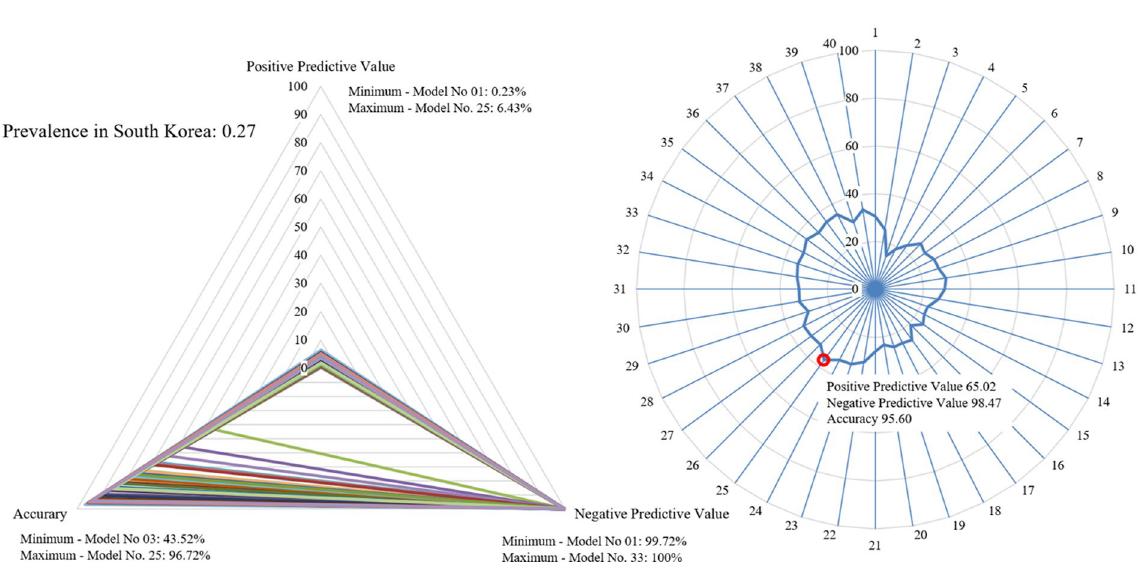
Figure 6. Comparison of each model considering screening performance affected by prevalence: South Korea. Triangle radar chart: positive predictive values, negative predictive values and accuracy of each model; polygonal radar chart: triangle radar chart area ratio in each